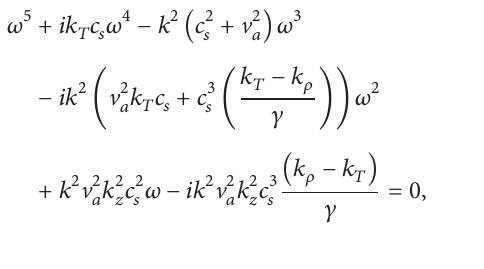
corresponds to the parallel wave propagating towards the positive 𝑧 -direction, whereas 𝜔 2 corresponds to antiparallel wave propagating towards negative 𝑧 -direction. The damping time is 𝜏 𝑑 = 1/𝜔 𝑖 and damping per period is 𝐷 𝑝 = 𝜔 𝑖 /𝜔 𝑟 . We plot Figures 1–6 to study the effect of flow on damping time and damping per period of these waves with